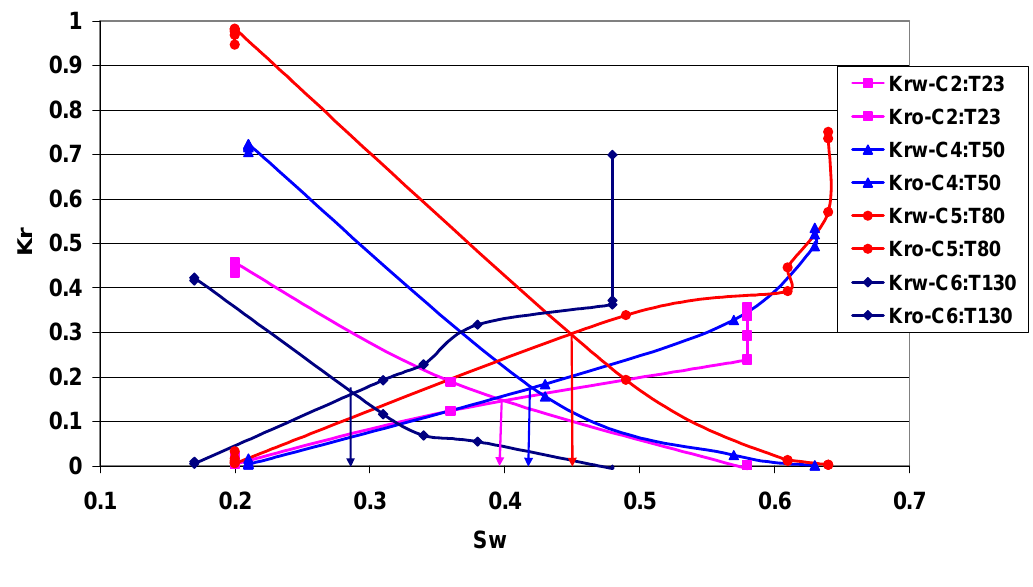
Figure 2. Effect of temperature on relative permeability for oil-wet chalk cores with 0.005MSA dissolved in decane. (From Hamouda et al.